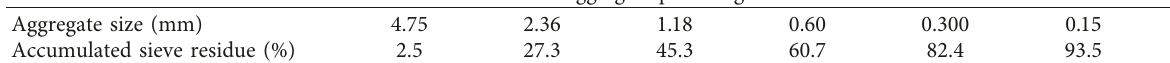
Table 5: Fine aggregate particle gradation.